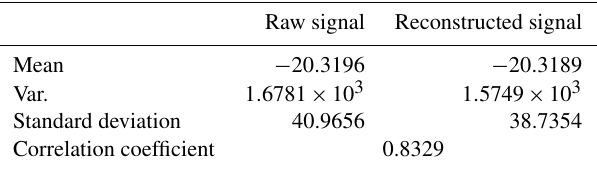
Table 4. Numerical analysis of raw and reconstructed